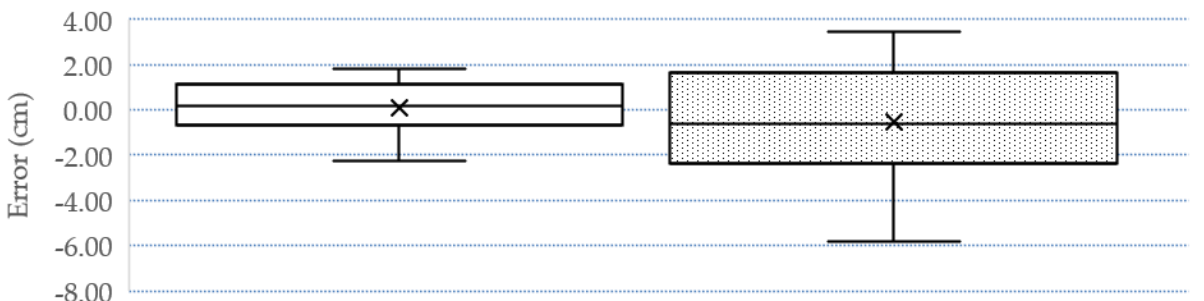
Figure 16. Tilapia Detection performance presented via box − plot estimated errors of length ( right ) and width ( left ) of Tilapia’s size.